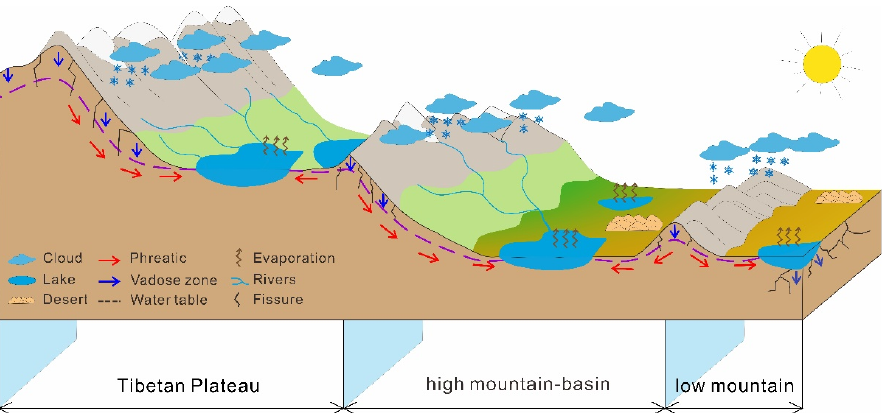
Figure 6. Schematic diagram of the lake basins of the Tibetan Plateau, high mountain—basin, and low mountain zones.